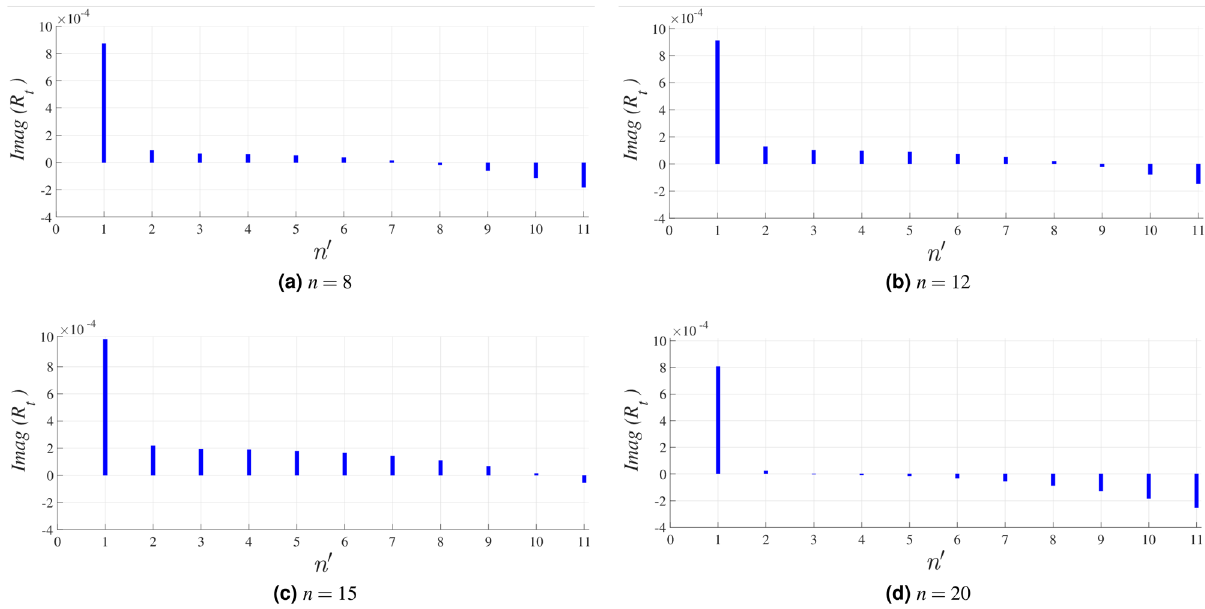
Figure 10. The imaginary part of R t in 4 different intervals of ϕ angle.